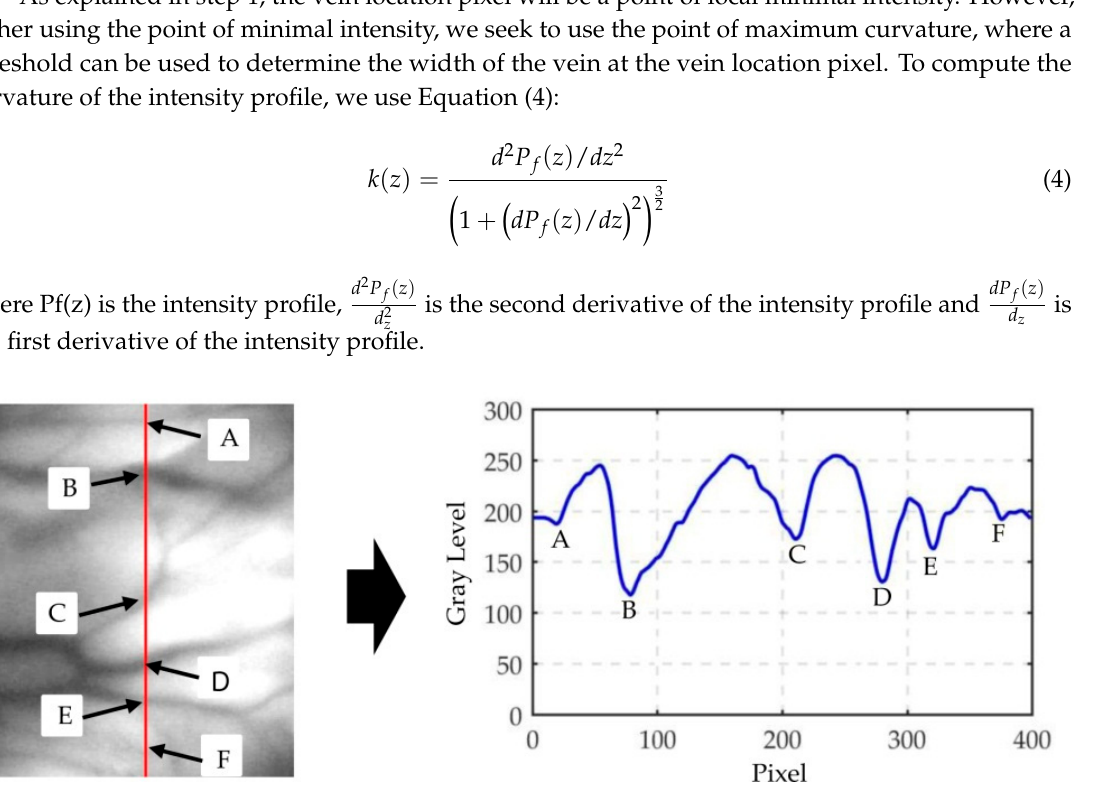
Figure 9. Intensity profiles in four directions: horizontal, vertical, left diagonal and right diagonal.